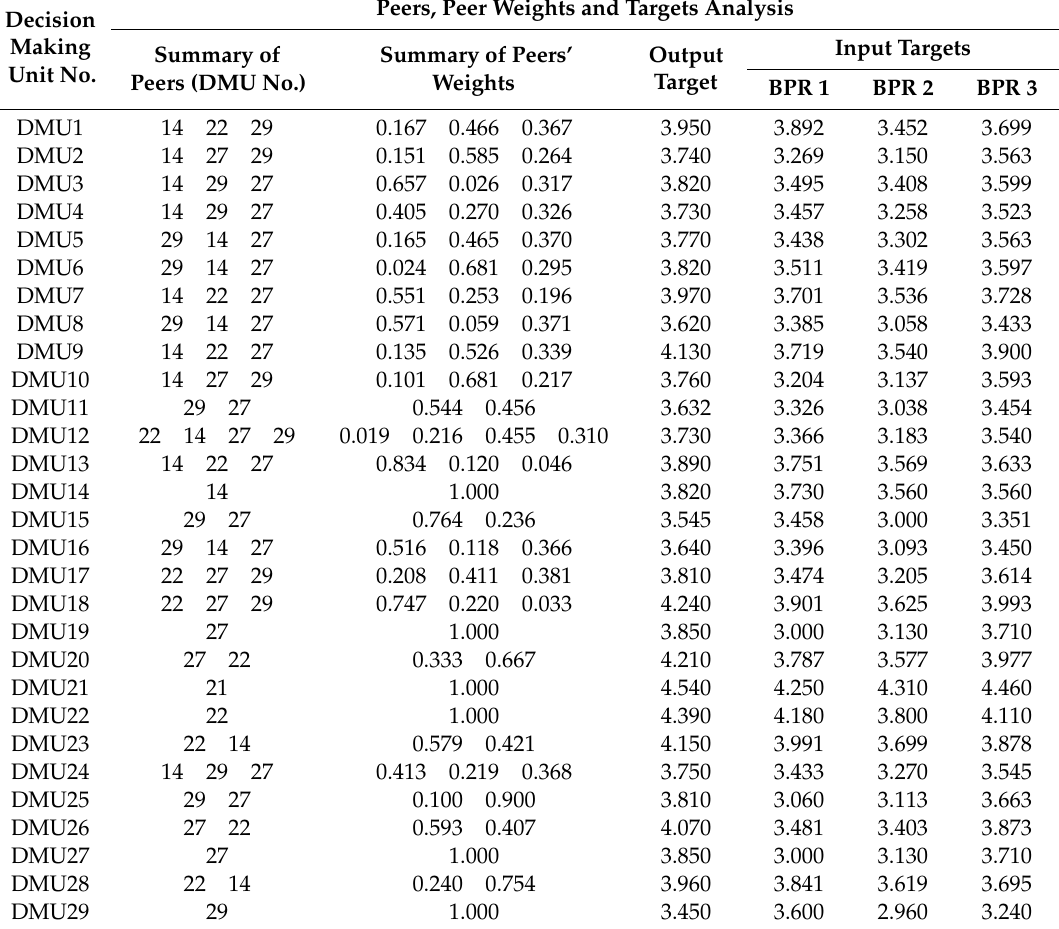
Table 4. Peers and Targets